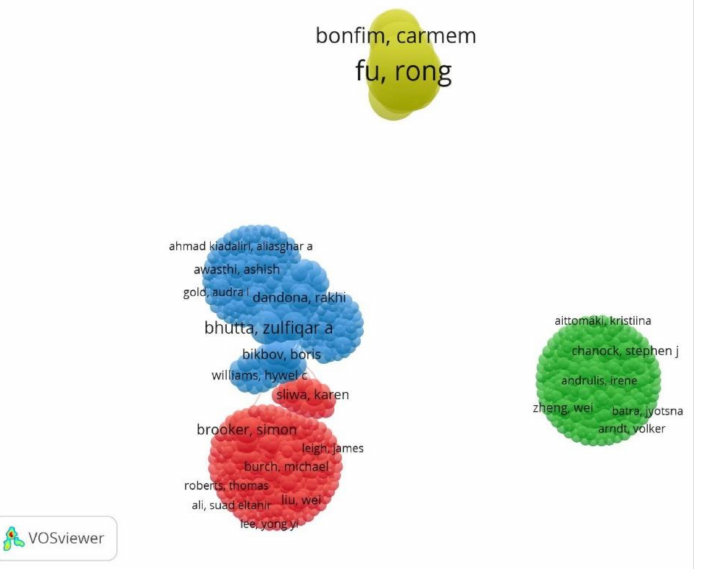
Figure 4. Collaboration networks between BRICS